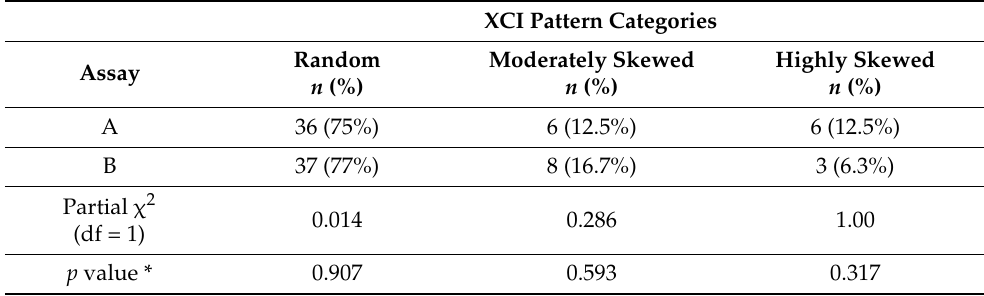
Table 2. Summary of the results obtained in the forty-eight